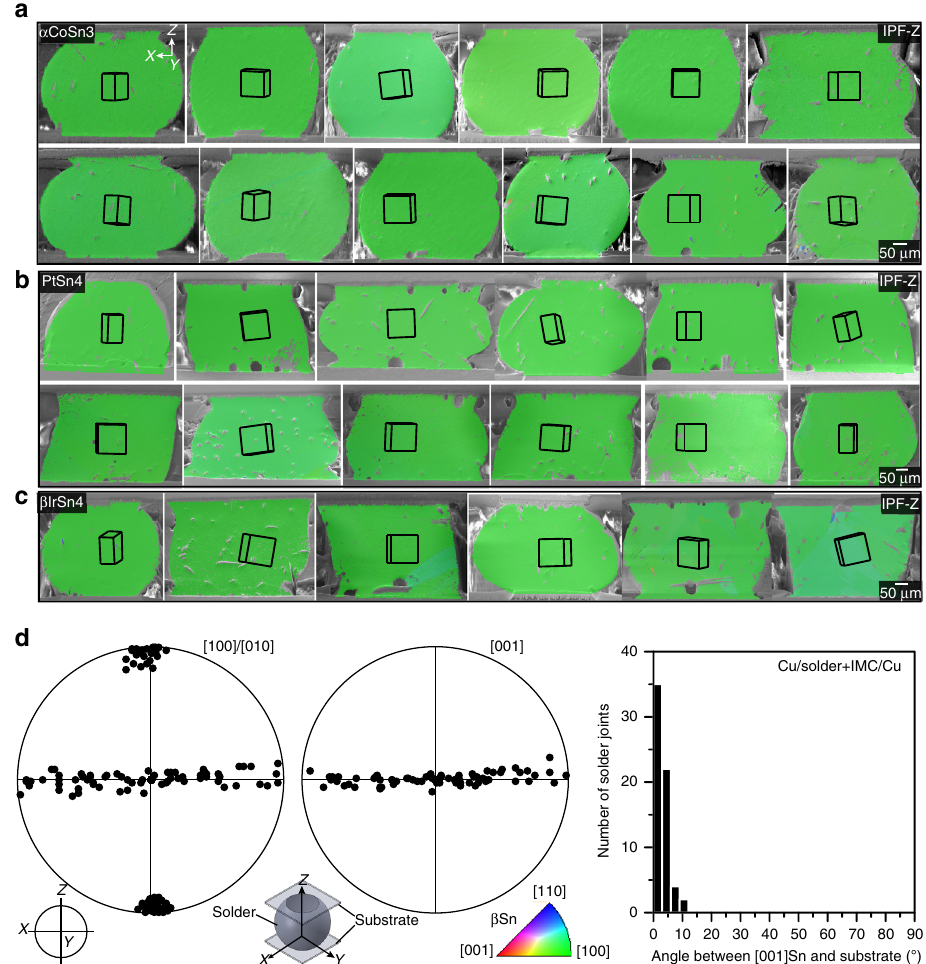
Fig. 6 c -axis orientation control in Cu/Sn-3Ag-0.5Cu or Sn-3.5Ag + nucleant/Cu joints. a – c Typical EBSD IPF-Z maps and unit cell wireframes. a α CoSn 3 , b PtSn 4 , and c β IrSn 4 . d Summarized β Sn pole fi gures of 67 solder joints and a histogram of the angles between [001]Sn of these joints and the substrate plane. This range of orientations is optimum for resisting electromigration according to refs 18 –